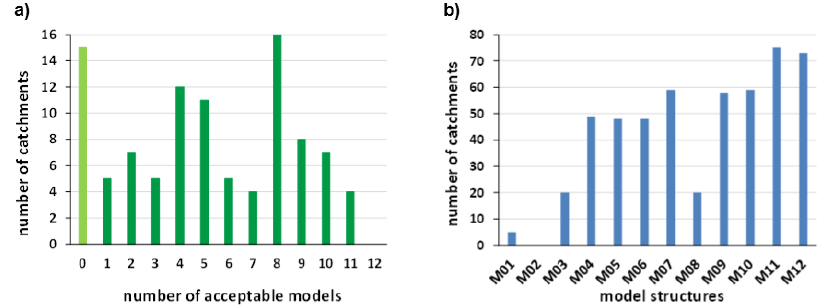
Figure 5. Numbers of acceptable models per catchment ( a ) and number of catchments where model structures M01 to M12 produce acceptable models ( b ).